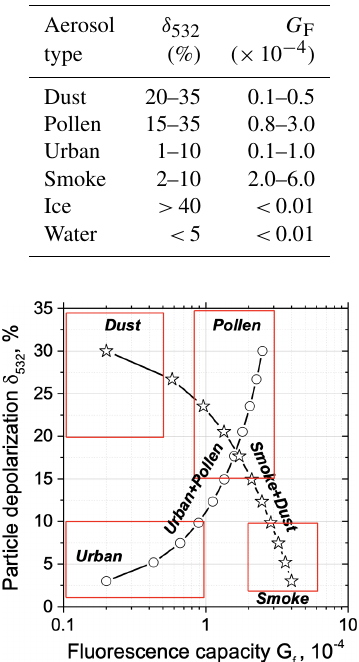
Figure 3. Aerosol type with a δ 532 - G F diagram. The ranges of the particle parameter variations for dust, pollen, smoke, and urban aerosol are given by rectangles. The symbols show the results of simulation performed for pollen and urban (circles) and smoke and dust (stars) mixtures. The relative contribution of pollen (smoke) to the total backscattering β 532 varied in the 0–1.0 range, with steps of 0.1. The particle parameters used in the calculations are given in the